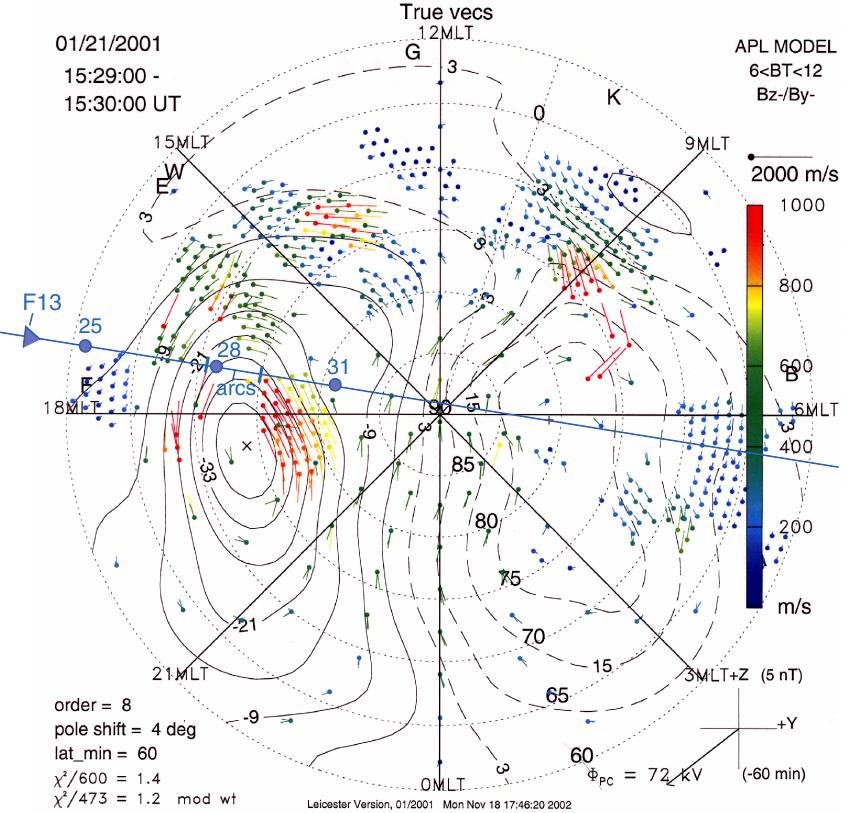
Fig. 2. Observations of flow channel FC 2 by SuperDARN radars during the NH-dusk/ B y < 0 case at 15:30UT on 21 January 2001. The coordinate system is MLAT/MLT. The track of spacecraft DMSP F 13 during a crossing of duskside arcs (15:28–15:29UT; 70–74 ◦ MLAT) and flow channel FC 2 (15:29–15:31UT; 74–80 ◦ MLAT/17:00–19:00MLT) on 21 January 2001 is shown by the blue line. From Sandholt et al.